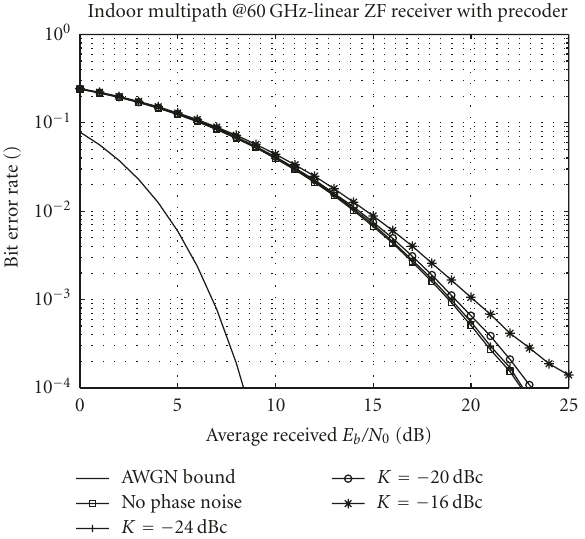
Figure 15: Impact of quantization on the BER performance of CPM.